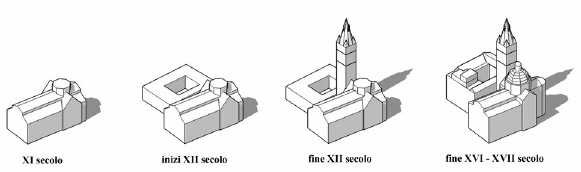
Figure 2. Schematic reconstruction of the constructive phases of the architectural complex of S. Maria delle Vigne